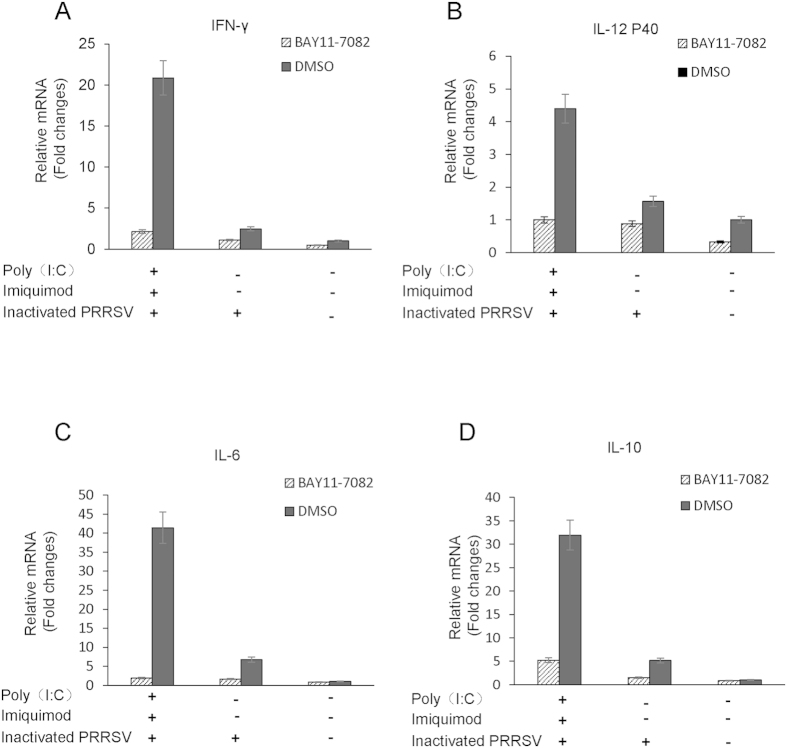
The mRNA levels of cytokines in MoDCs pretreated with NF-κB inhibitor BAY11-7082 or DMSO and then stimulated with poly (I: C) and imiquimod along with inactivated PRRSV antigen.MoDCs were pretreated with BAY11-7082 (5 μM) or DMSO for 2 h, then were incubated with poly (I: C) and imiquimod along with inactivated PRRSV antigen for 12 h, the inactivated PRRSV antigen and RPMI-1640 were used as control. The transcript levels of IFN-γ, IL-12 P40, IL-6 and IL-10 in MoDCs were analyzed by real-time RT-PCR. Relative transcript levels are shown as fold changes relative to the level for the control cells of the RPMI-1640 group. The data represent the means of three independent experiments, with each experiment performed in triplicate. Data represent the means ± standard deviations (error bars) of three independent experiments.